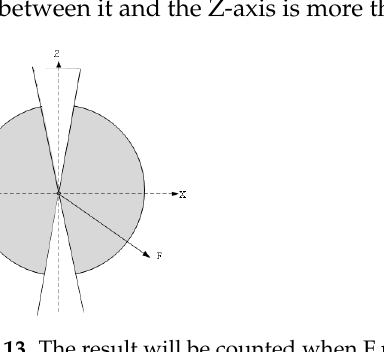
Figure 13. The result will be counted when F point to the shaded area.